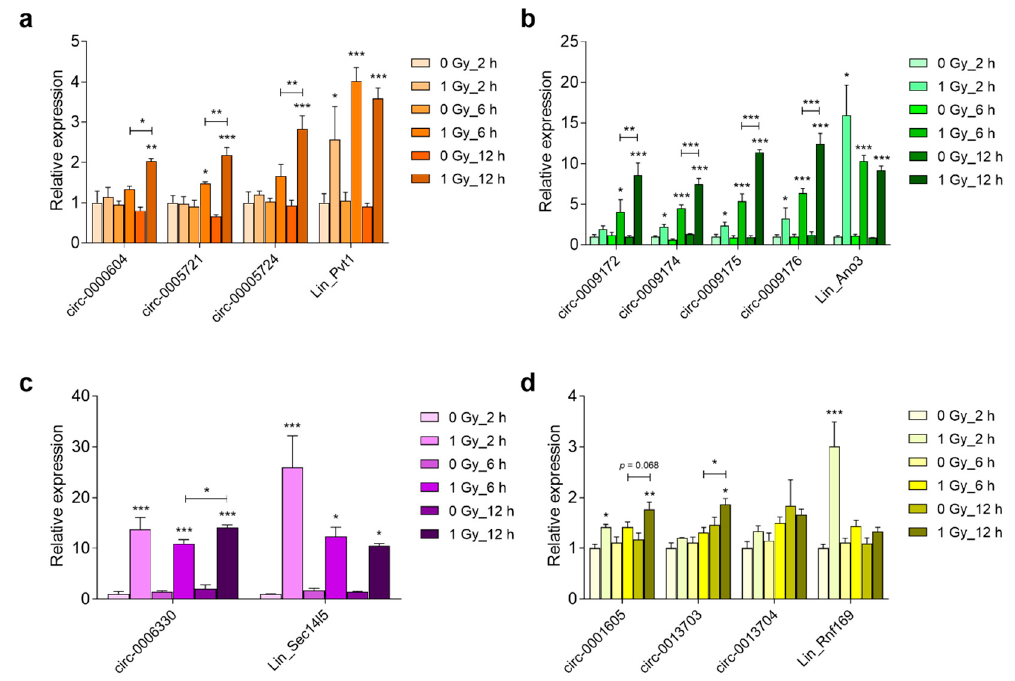
Figure 7. Radiation-induced RNA abundance in the embryonic brain. Relative levels of linear and circular ( a ) Pvt1; ( b ) ; Ano3; ( c ) Sec14l5, and ( d ) Rnf169 was determined by RT-qPCR in the brain 2 h, 6 h, and 12 h after irradiation of E11 embryos. Data shown are means + s.e.m. of three biological replicates and have been normalized against 0 Gy_2 h. Statistics were performed using two-way ANOVA with correction for multiple comparisons while using the two-stage step-up method of Benjamini, Krieger, and Yekutieli; * p < 0.05; ** p < 0.01; *** p <